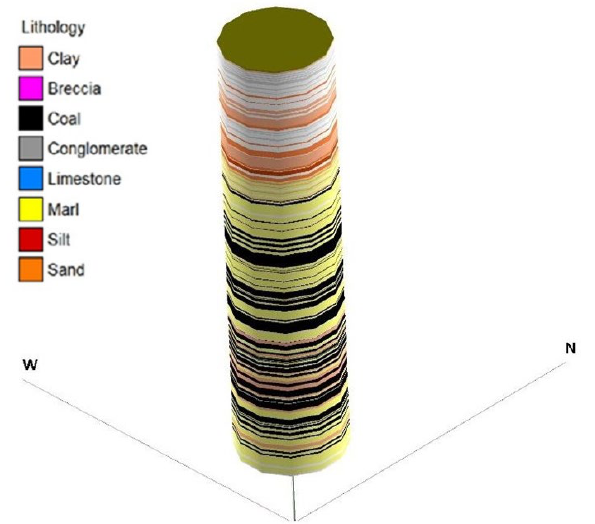
Figure 8. Sample profile of the T6D-070 borehole (Vertical Exaggeration =3x, 1350/320 compass bearing/angle from the horizon). The development of the 3-D model of the study area was created with RockWorks version 17 (standard license).